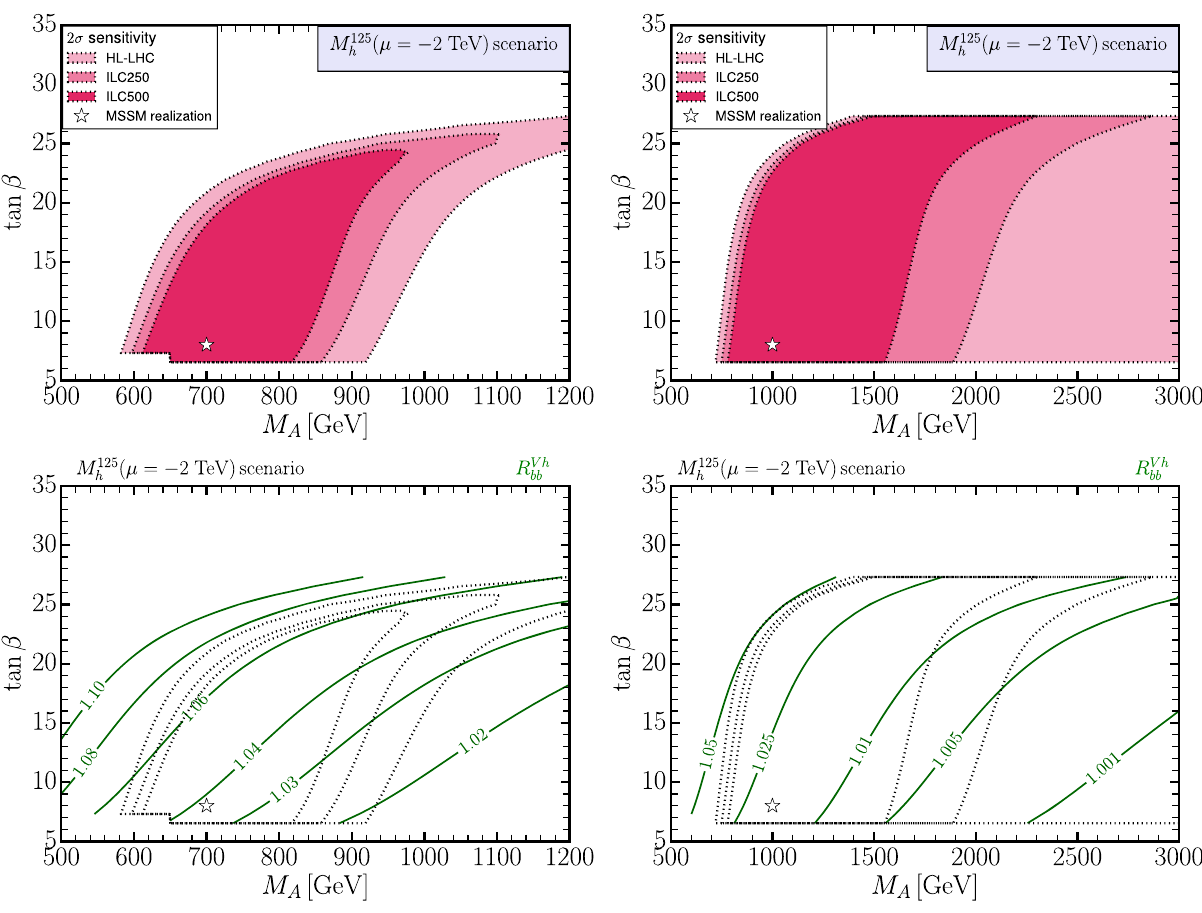
, tan β) = ( 700 GeV , 8 ) (left panels) or ( M ( M A (right panels) is realized in nature. The same color coding as in Fig.8 is